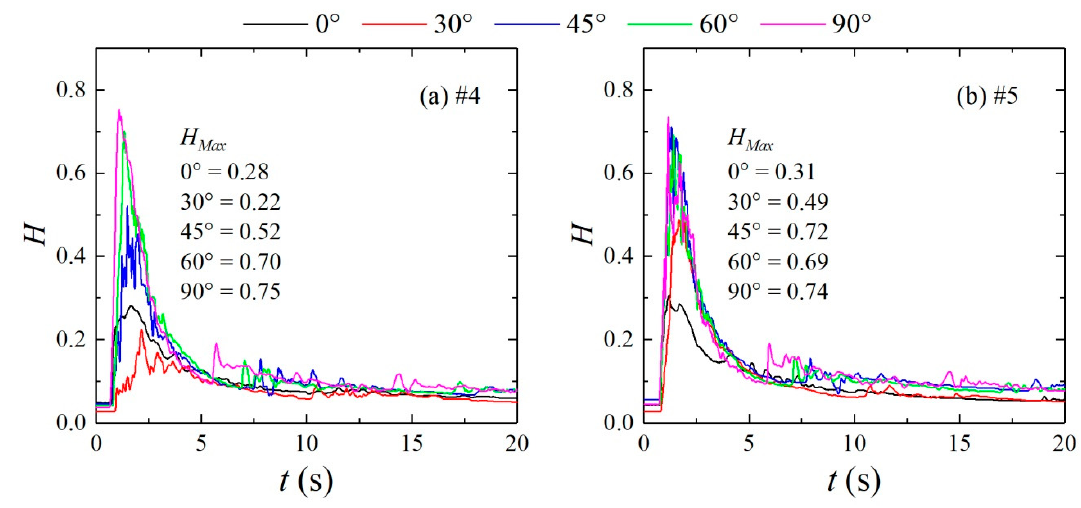
Figure 7. Variations in the water depths of different configurations at measuring points #4 and #5 over time. ( a ): measuring points #4; ( b ): measuring points #5.